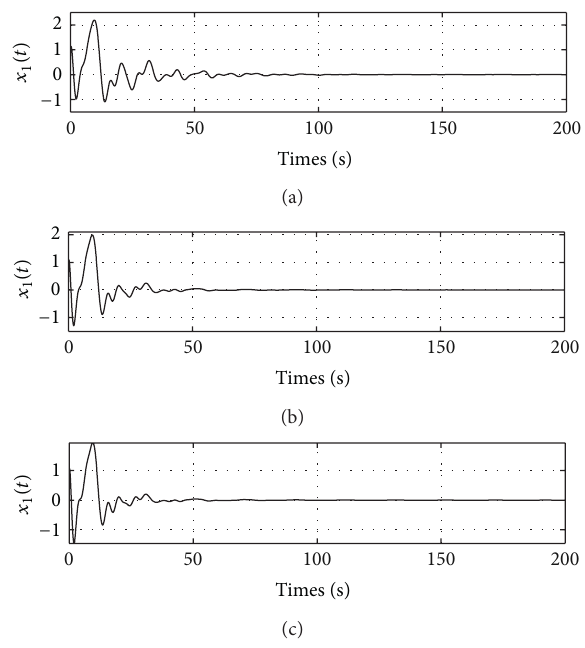
Figure 9: Effect of the number of prediction points on the displace- ment response: (a) Case 1 ( 𝑁 = 5 ), (b) Case 2 ( 𝑁 = 10 ), and (c) Case 3 ( 𝑁 = 15